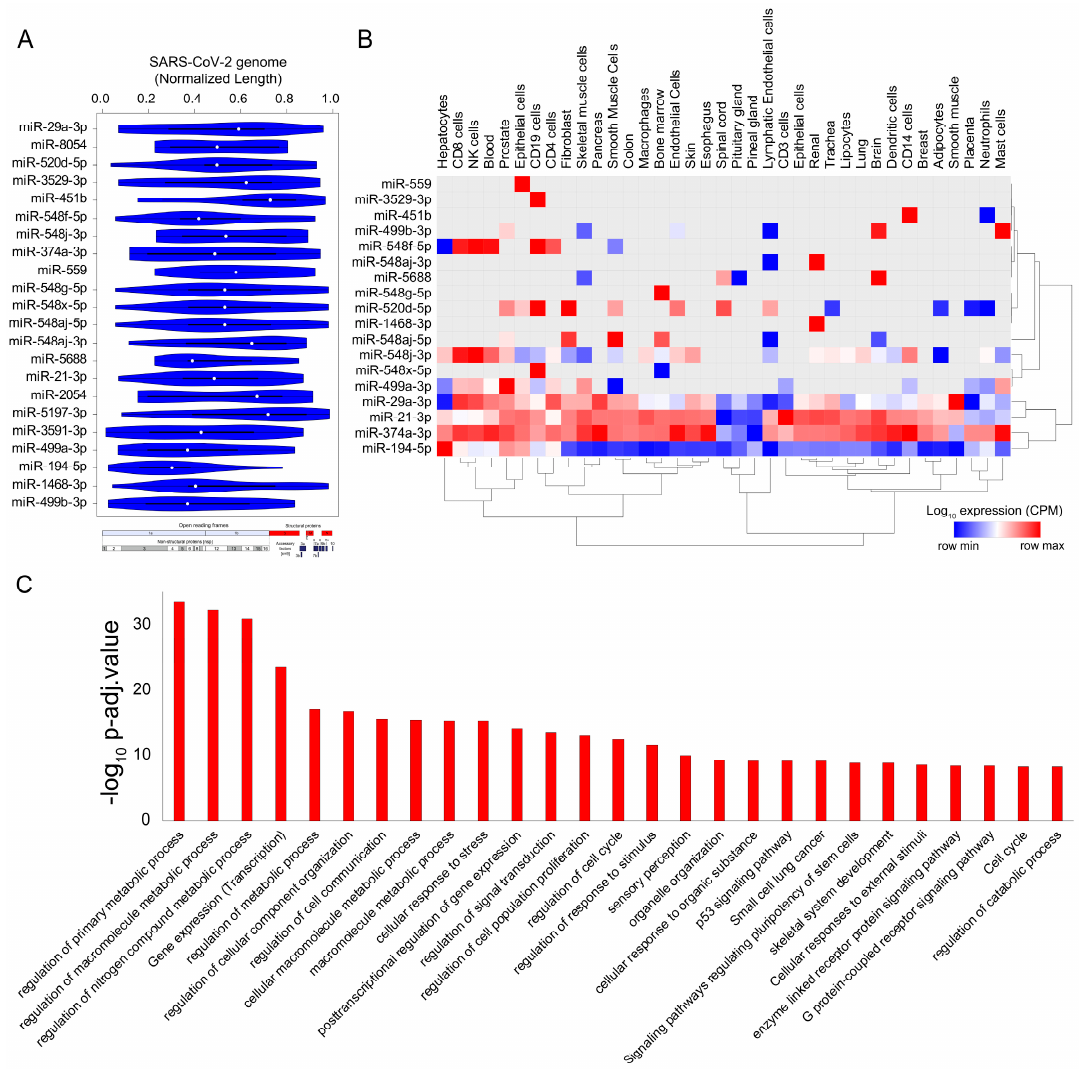
Figure 5. SARS-CoV-2 genome titrates the abundance of functionally important micro-RNAs (miRs) in human tissue. ( A ) Violin plot shows the statistically significant ( p < 1 × 10 − 5 ) preferential binding profile of miR motifs (sorted by frequency of binding > 15 sites) across the SARS-CoV-2 viral genome (length normalized) identified using FIMO. ( B ) Hierarchically clustered heatmap showing the log10 expression (Copies Per Million mapped reads (CPM), row normalized) of miRs across the tissues. ( C ) Bar plot illustrating the significant biological processes obtained from the gene ontology enrichment-based functional grouping of miR target genes (obtained from miRNet). Significant clustering (adj. p < 1 × 10 − 10 ) of genes enriched in GO biological processes generated by ClueGO analysis (Cytoscape